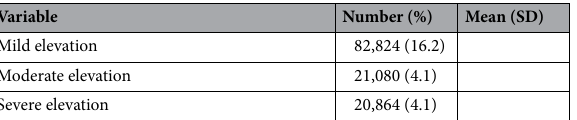
Table 1. The clinico-epidemiological characteristics of the participants (n = 512,746). SD, standard deviation; AST, aspartate transaminase; ALT, alanine aminotransferase; γ-GTP, γ-glutamyl